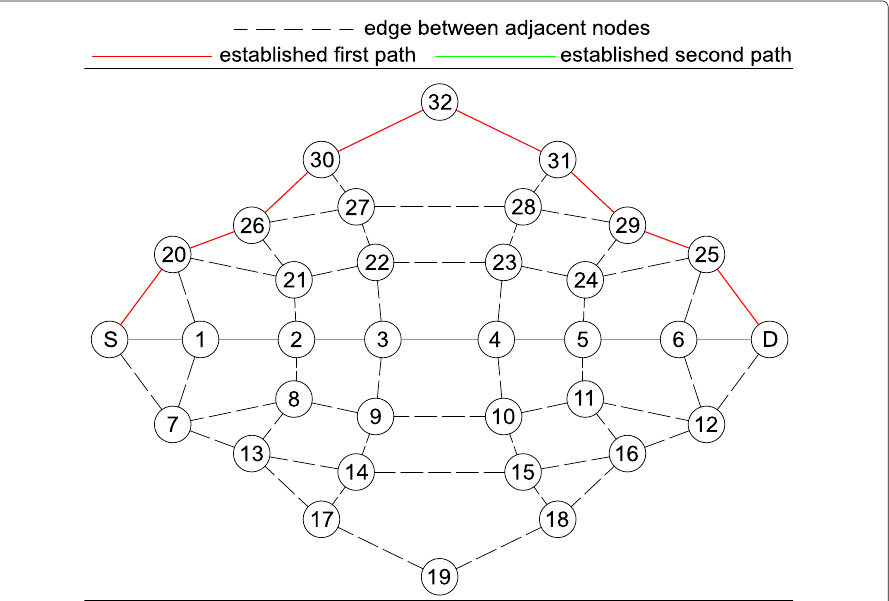
Fig. 2 Least Interefence Path Method. The first path, shown in red, is discovered by Dijkstra’s algorithm based on a graph with interference-based weighted edges. The second path, shown in green, is discovered by a simple breadth-first search